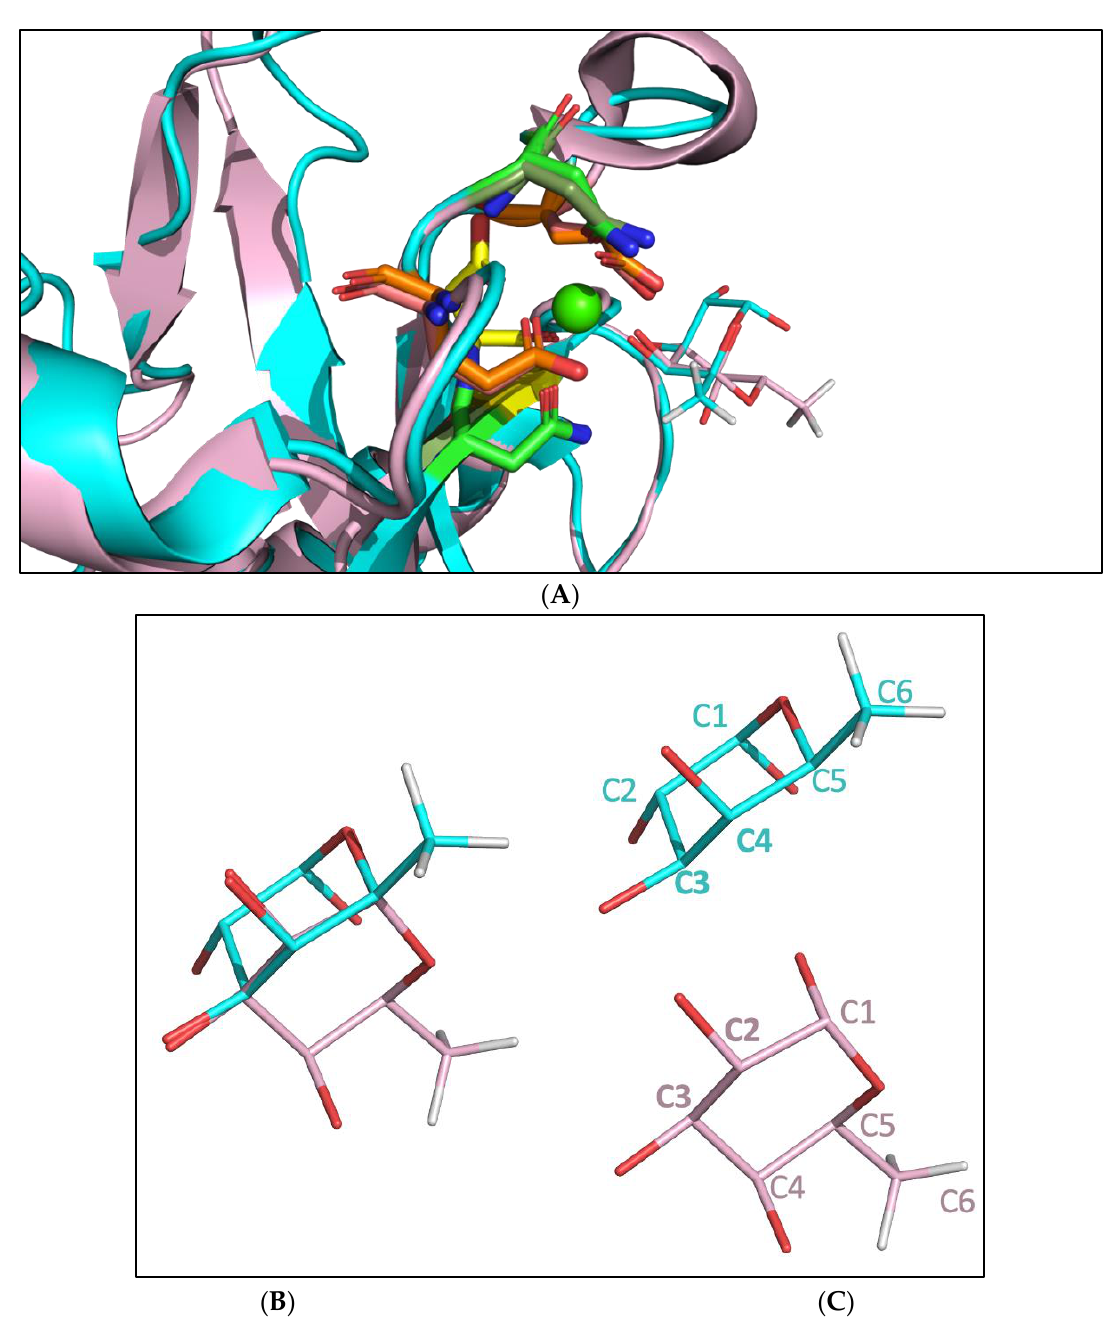
Figure 5. ( A ): Both DC-SIGN (cyan) and langerin (light pink) have been aligned. The residues interacting through the calcium ion (green ball) are displayed in sticks and fucose residues in the wire representation. Aspartic acid is shown in yellow, asparagine is shown in green, and glutamic acid is shown in orange. Both proteins show the same residues and the same geometry on the binding site as can be observed in the superimposed image. ( B ): Superimposition of the two fucose poses, is shown to depict the significant orientation difference between the two fucoses. The hydrogens have been hidden in the figure, for clarity purposes, only the methyl group hydrogens are shown for a clear depiction of the orientation differences between the two fucoses. Only the fucose part of the whole ligands (LNFP III for DC-SIGN and blood group B trisaccharide for langerin) is shown here. ( C ) The two fucose poses are shown separately with the atom numbers, for